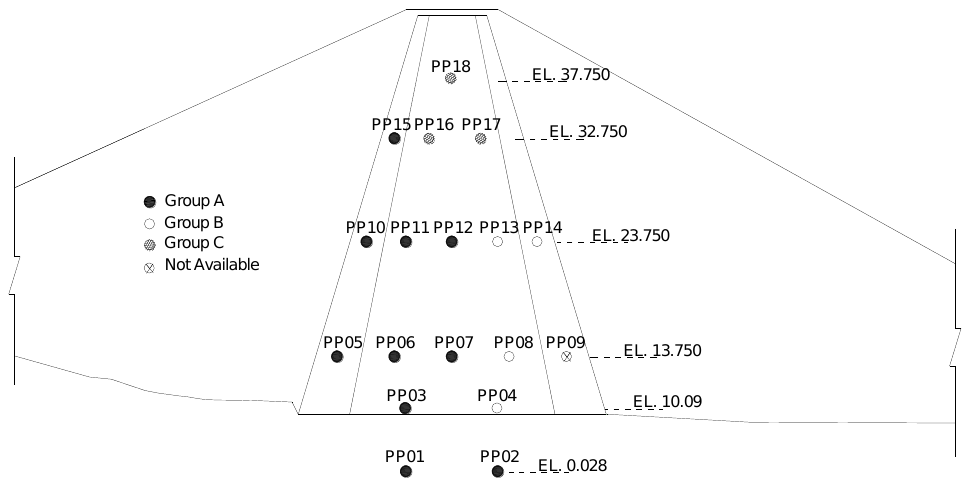
Figure 7. Distributions of porewater pressure transducers by PCA.